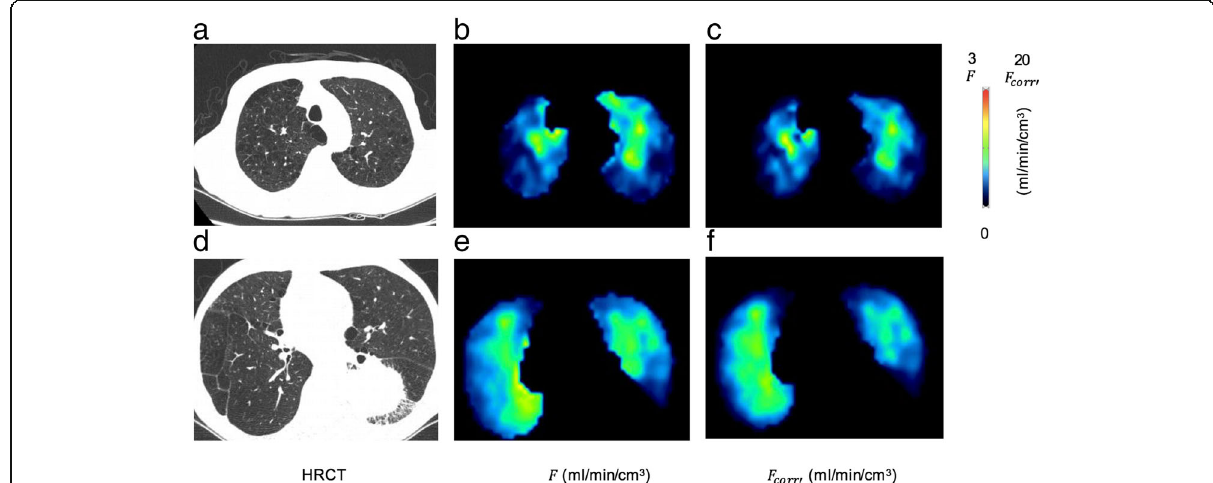
Fig. 4 HRCT image ( a ), PBF image without TF correction ( b ), PBF image with TF and blood volume correction ( c ) of apical area and those of basal area ( d - f ) in patient 9, who had left lower lobe lung cancer and emphysematous